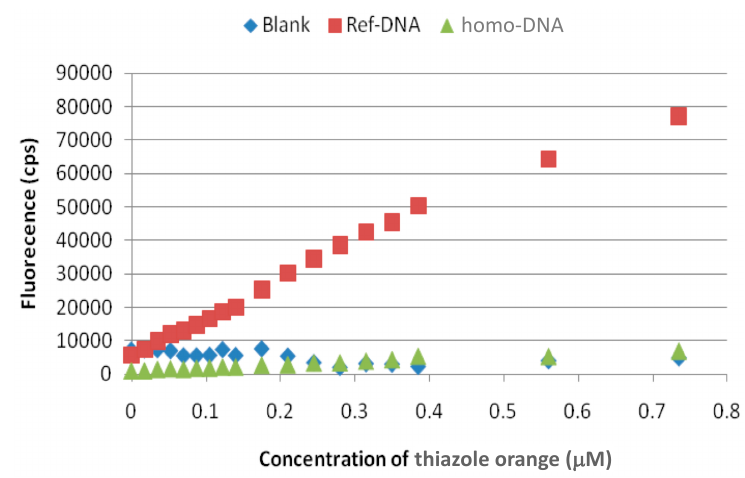
Figure 4. Fluorescence intercalation assay. The thiazole orange dye exhibited dose-dependent fluorescence upon addition to DNA [d(CGAATTCG)] 2 (red squares), but not homo-DNA [dd(CGAATTCG)] 2 (green triangles), consistent with intercalation only into the former duplex type.